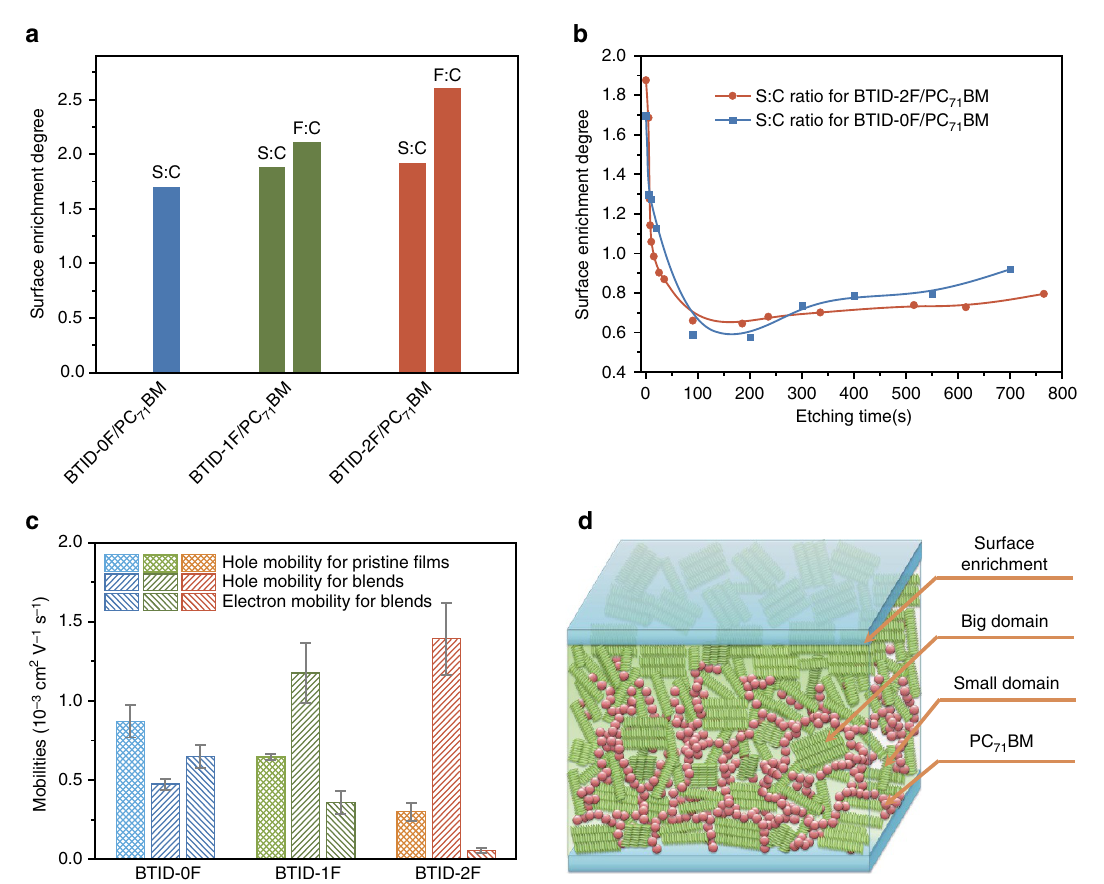
Figure 5 | Vertical morphologies of blended films. ( a ) Surface enrichments of BTID-0F/PC 71 BM, BTID-1F/PC 71 BM and BTID-2F/PC 71 BM on ZnO/ITO substrate; ( b ) in-depth XPS profiles of BTID-0F/PC 71 BM and BTID-2F/PC 71 BM on ZnO/ITO substrates, the line were obtained from fitting all the S:C value from various etching time; ( c ) carrier mobilities of blends and pristine films, the average values were obtained from the mobility measured from the thickness between 100 and 130nm, the error bars come from the mobility value from thickness differences and their measurements errors; and ( d ) schematic illustrations of lateral and vertical phase distribution of BTID-2F/PC 71